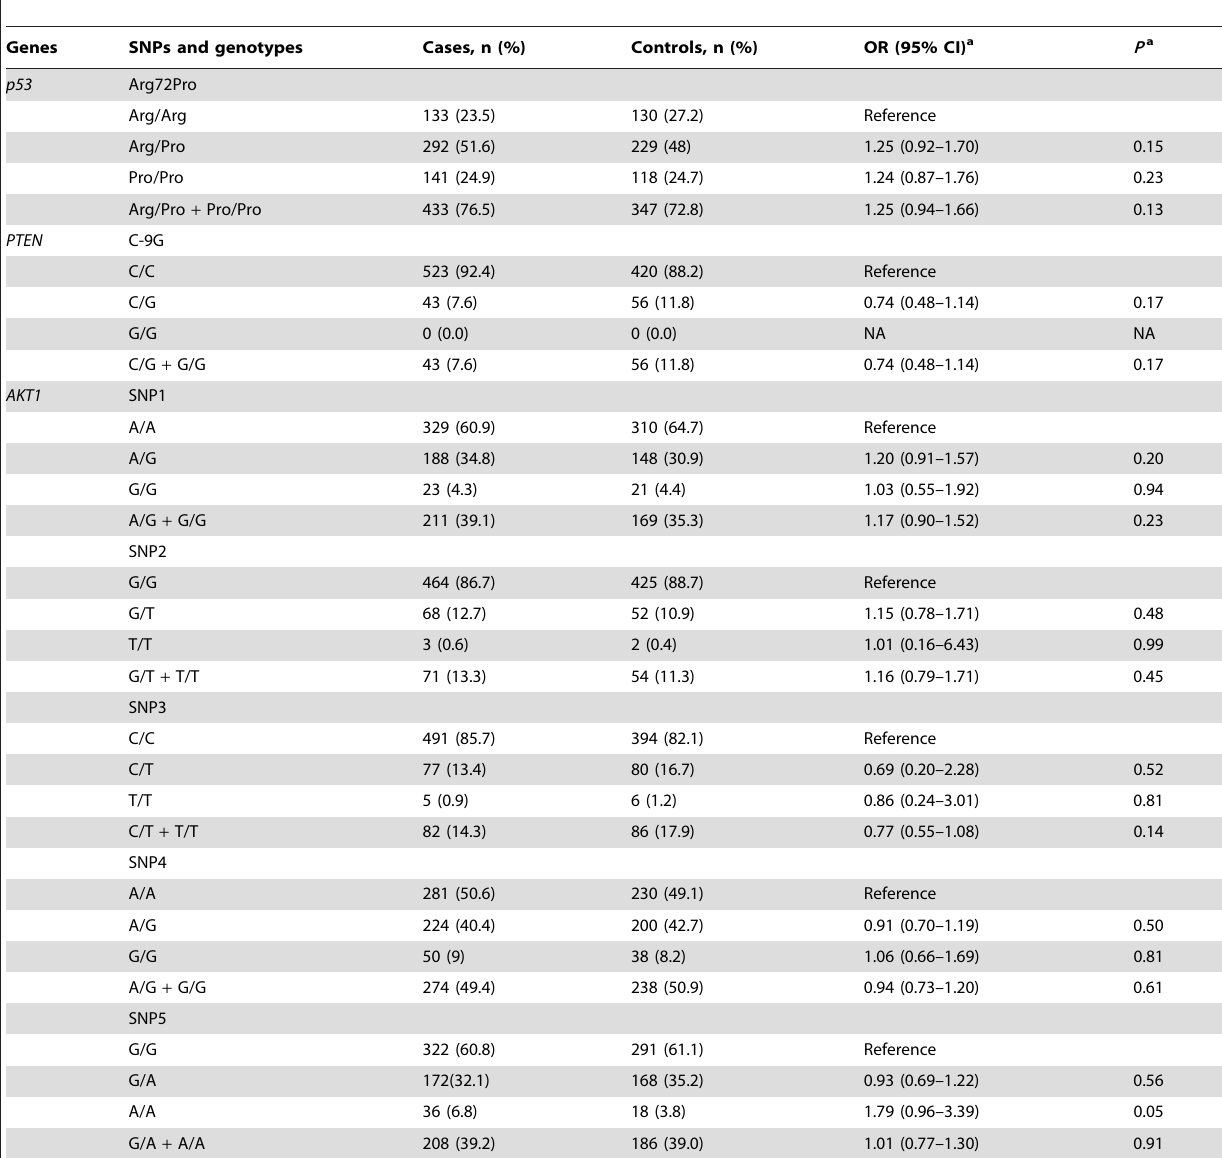
Table 2. The genotype frequencies of polymorphisms in the PTEN , AKT1 and p53 genes in patients with nasopharyngeal carcinoma and